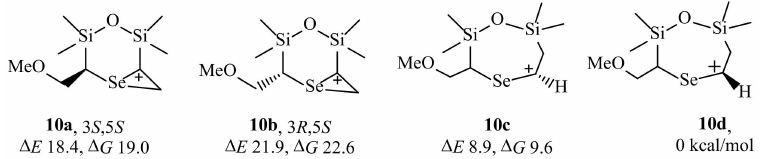
Figure 4. The relative total and free energies of all cations 10 with respect to the most stable cation 10d